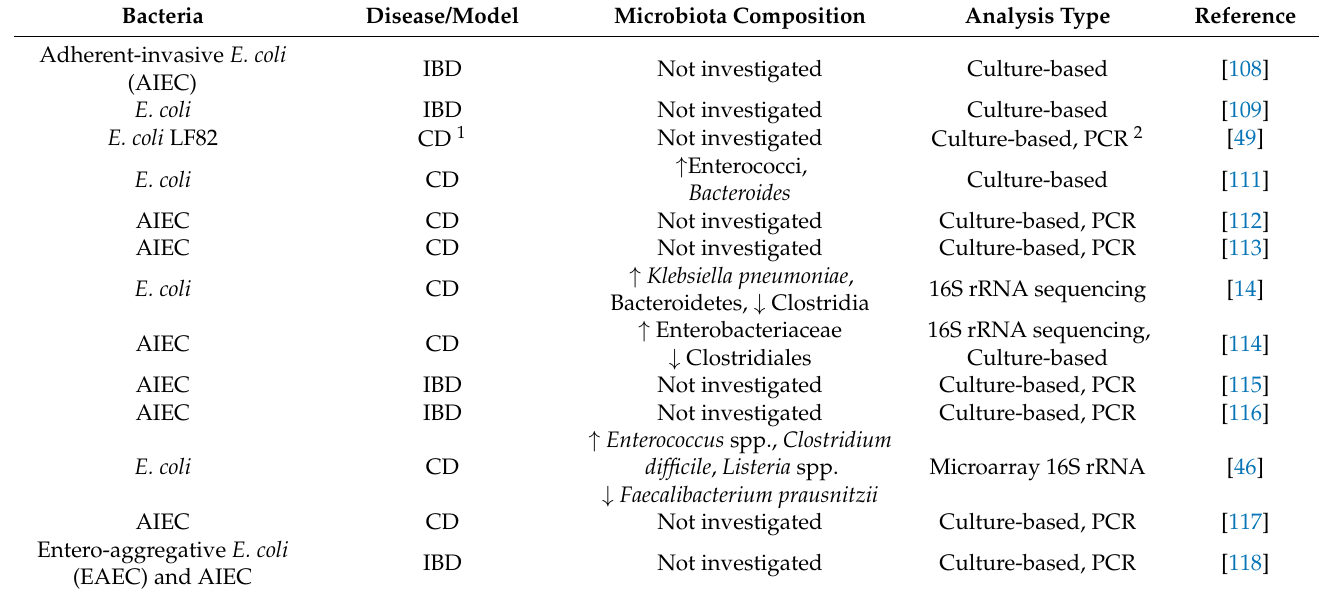
Table 1. Escherichia coli strains identified in human and in animal models of inflammatory bowel diseases (IBDs).